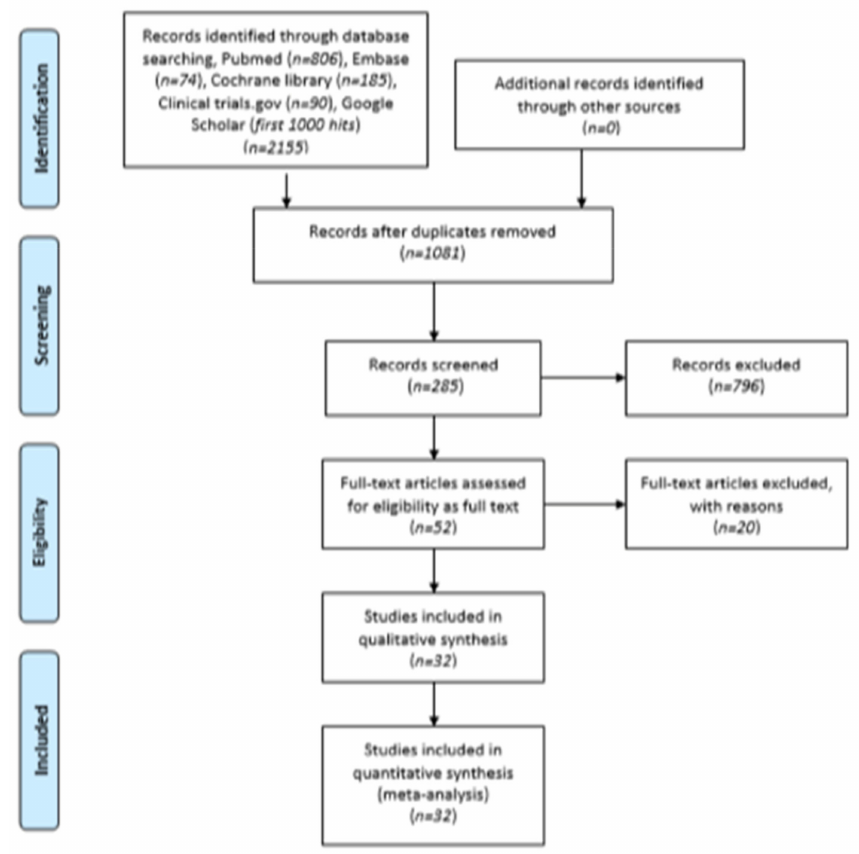
Figure 1. PRISMA flow